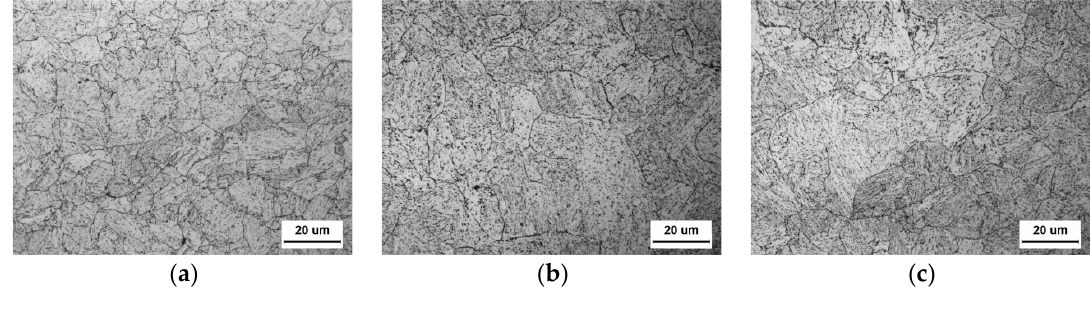
Figure 2. Prior austenite grain of the specimen at different positions: ( a ) 10 mm, ( b ) 30 mm and ( c ) 60 mm. Table 3. Quantitative results of the microstructure at different positions.